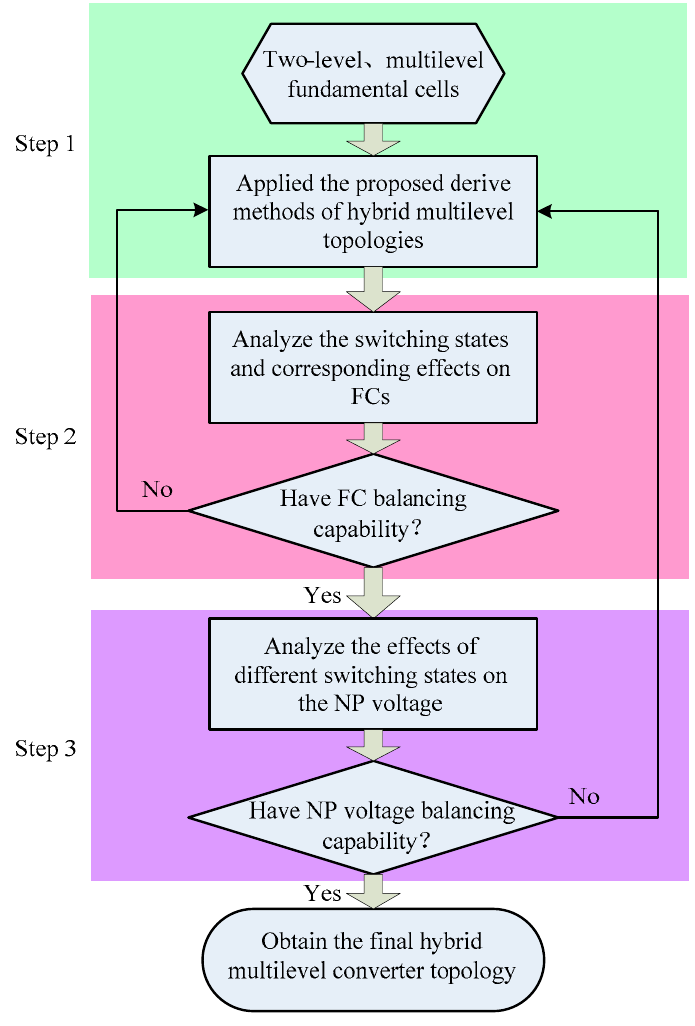
Figure 21. Derivation process of the HMCs.